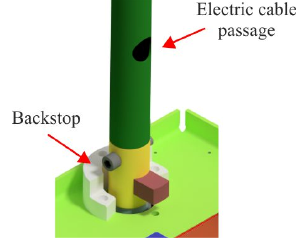
Figure 11. Backstop system to restrict the steering